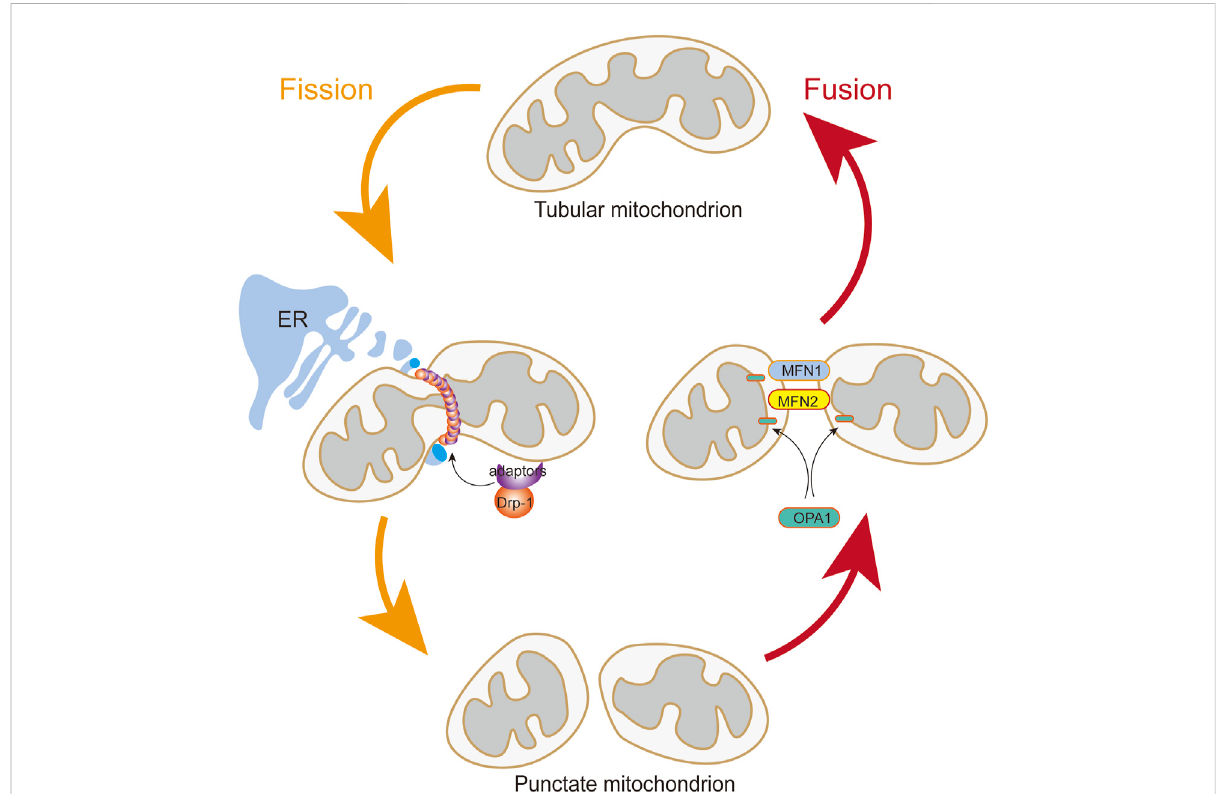
FIGURE 2 MitochondrialFusionandFission.ThetranslocationofDrp1totheoutermitochondrialmembranefromthecytosolisinducedbyDrp1adapters when DRP1 is activated. Assembly of the fi ssion apparatus is in the outer mitochondrial membrane that are aggregated in a microenvironment shaped by contact with the endoplasmic reticulum. Mitochondrial fusion is mediated bythe coordinatedactivitiesof mitofusins (MFN1 and MFN2)in the outer mitochondrial membrane and OPA1 in the inner mitochondrial